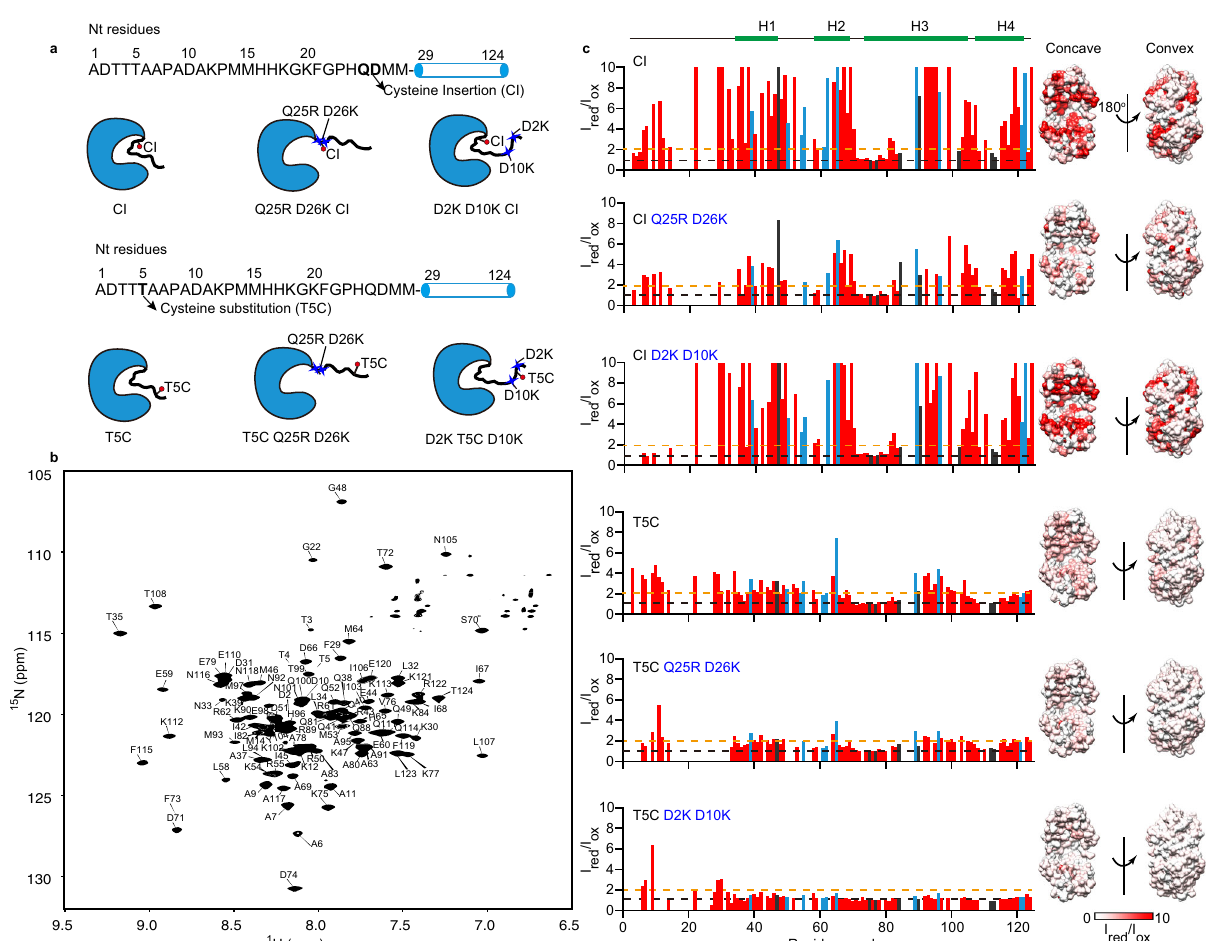
Fig. 3 Electrostatic interactions mediate the swing of the N terminus of Spy toward its positively charged concave surface. a Illustrations of Spy variants used in intramolecular PRE experiments. The positions for cysteine insertion or substitution are indicated by arrows. The diagrams are schematic illustration for the different positions of the N terminus relative to the structured region of Spy due to various mutations on Spy ’ s N terminus. b The two- dimensional (2D) [ 15 N, 1 H]- transverse relaxation-optimized spectroscopy (TROSY) spectrum of 400 μ M [ 2 H, 13 C, 15 N]-labeled Spy 1-124 in a solution of 40 mM HEPES, 150 mM NaCl with 0.03% NaN 3 (w/v) and 10% D 2 O, pH 7.5. Sequence-speci fi c resonance assignments of the backbone amide groups are labeled. c Intramolecular PRE effect of a spin label on 15 N-labeled Spy 1-124 variants with a cysteine inserted after residue Q25 (CI) or substituted for T5 (T5C) along with combinatorial substitutions of Q25R D26K or D2K D10K. A paramagnetic spin label (MTSL) was attached to CI or T5C. The PRE effects were presented by the ratios of peak intensities before and after the reduction of the spin label ( I red / I ox ). PRE intensity ratios of 1 and 2 are indicated by black and orange dashed lines, respectively. Positively charged residues with side chains pointing to the concave or convex surfaces of Spy are marked in light blue and black, respectively. Surface presentations of Spy 29-124 (PDB: 3O39), colored according to the PRE intensity ratios are displayed to the right. The white-to-red color scale indicates PRE intensity ratios ( I red / I ox ) ranging from 0 to 10. Source data are provided as a Source Data fi